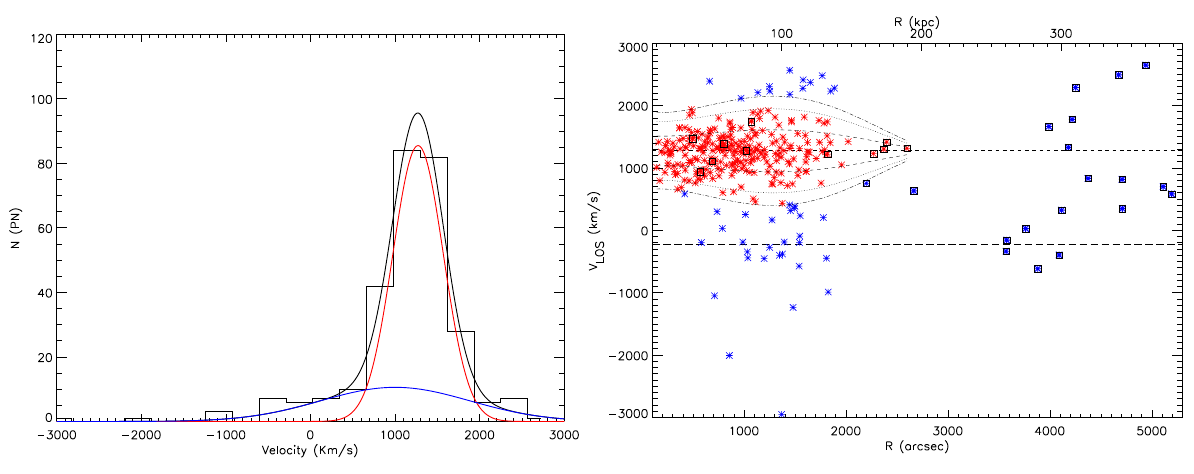
Figure 2. ( Left ): Line-of-sight velocities distribution (LOSVD) of the spectroscopically confirmed PNs, fit with a double Gaussian (black line). The M87 halo and intracluster light (ICL) Gaussian components are shown by the red and blue lines, respectively; ( Right ): LOSV plotted against major axis distance from the centre of M87 for all of the spectroscopically confirmed PNs from [15] (stars) and [18] (black-squares). The M87 halo PNs bound are denoted in red, and the ICPNs are shown in blue. The smoothed 1, 2 and 2.5 sigma thresholds are represented by the dashed, dotted and dot-dashed lines, respectively. The dashed, and long dashed lines denote M87 and M86 systemic velocities,